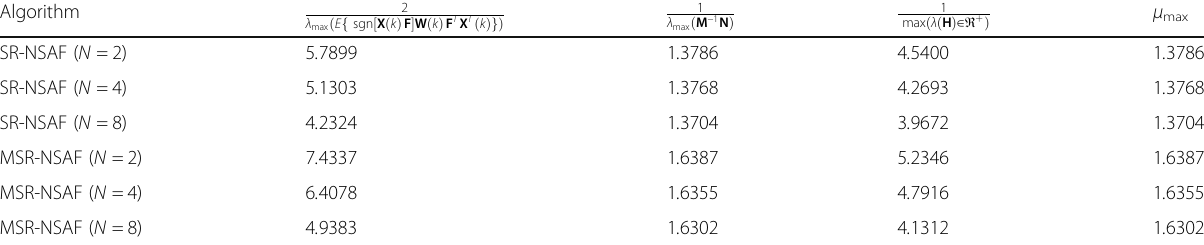
Table 6 Stability bounds of the SR-NSAF and MSR-NSAF for different values of N Algorithm